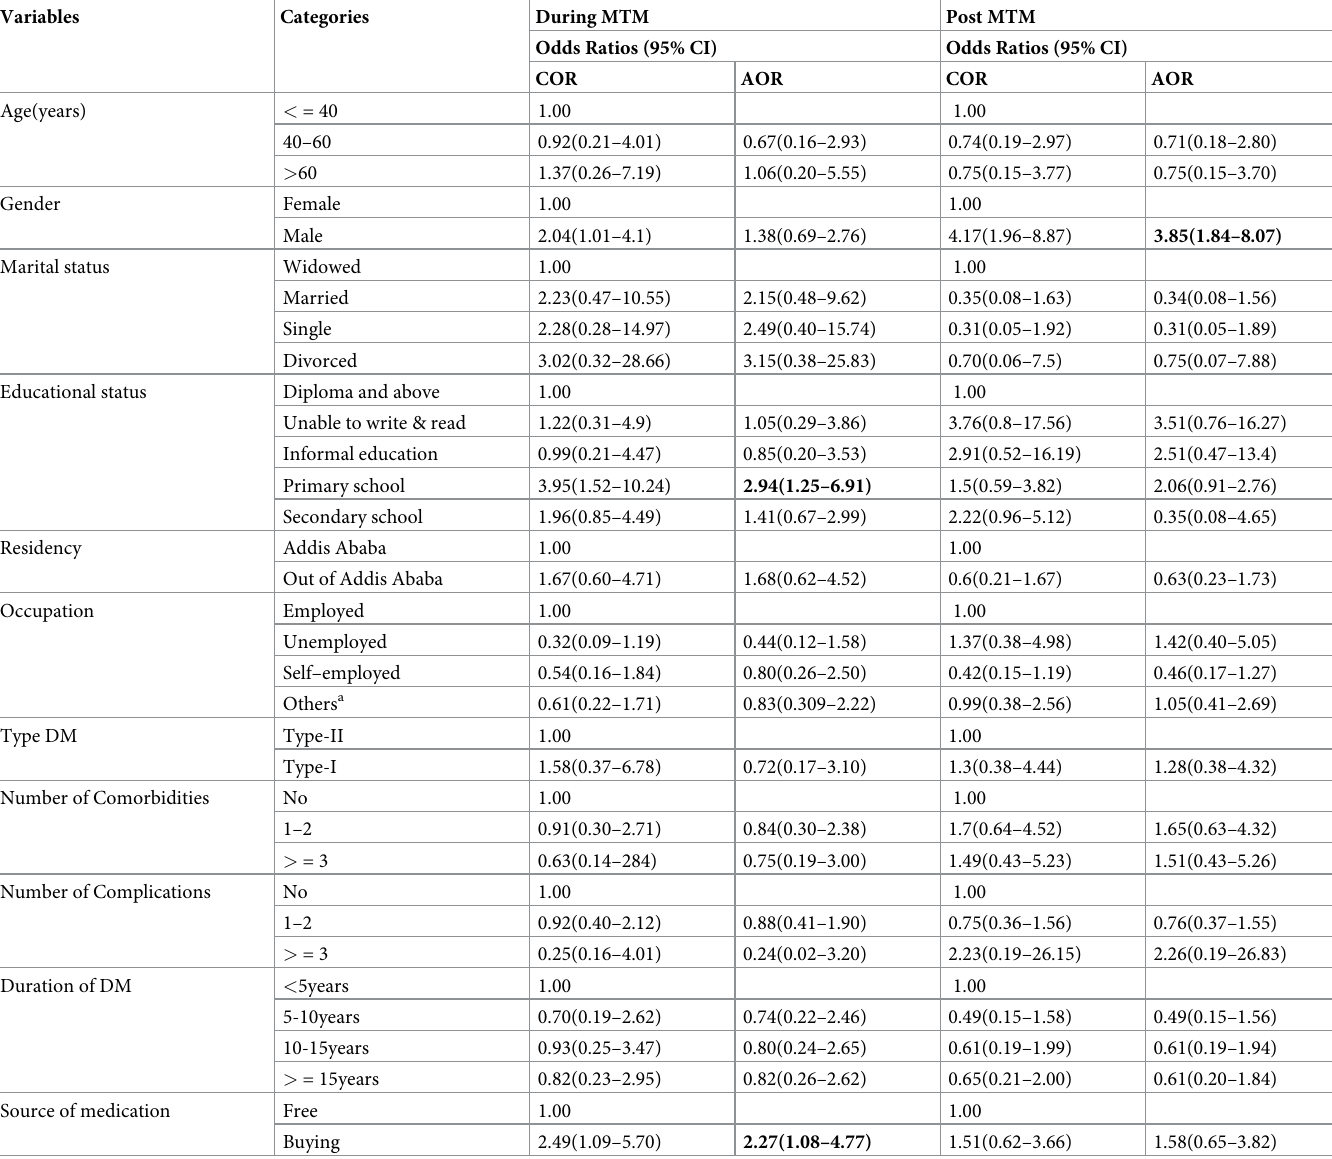
Table 4. Bivariate and multivariate analysis of factors associated with drug therapy problems among adult patients with